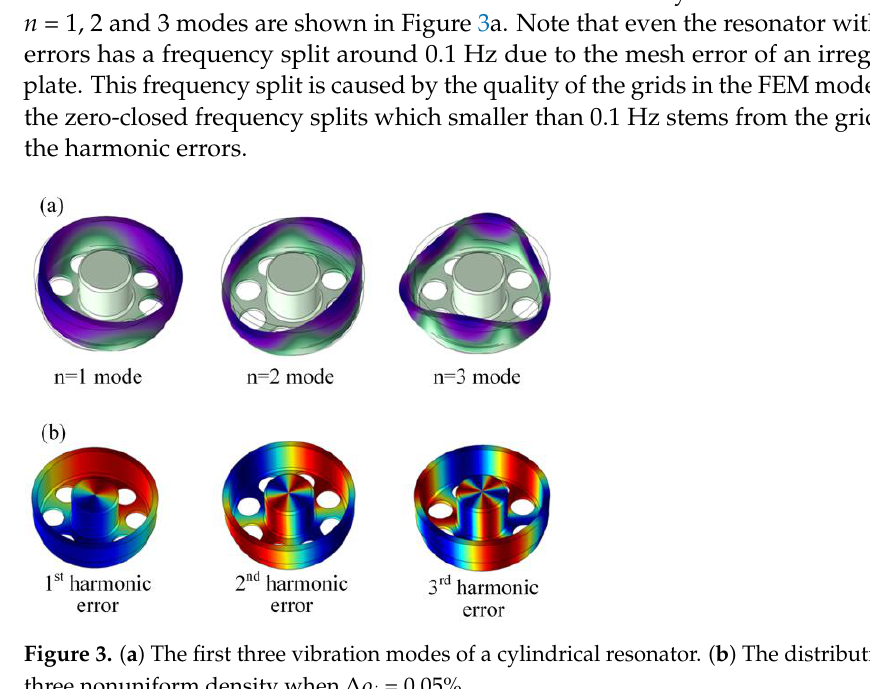
Figure 3. ( a ) The first three vibration modes of a cylindrical resonator. ( b ) The distribution of the three nonuniform density when ∆ ρ i = first three nonuniform density when Δ ρ i = 0.05%.